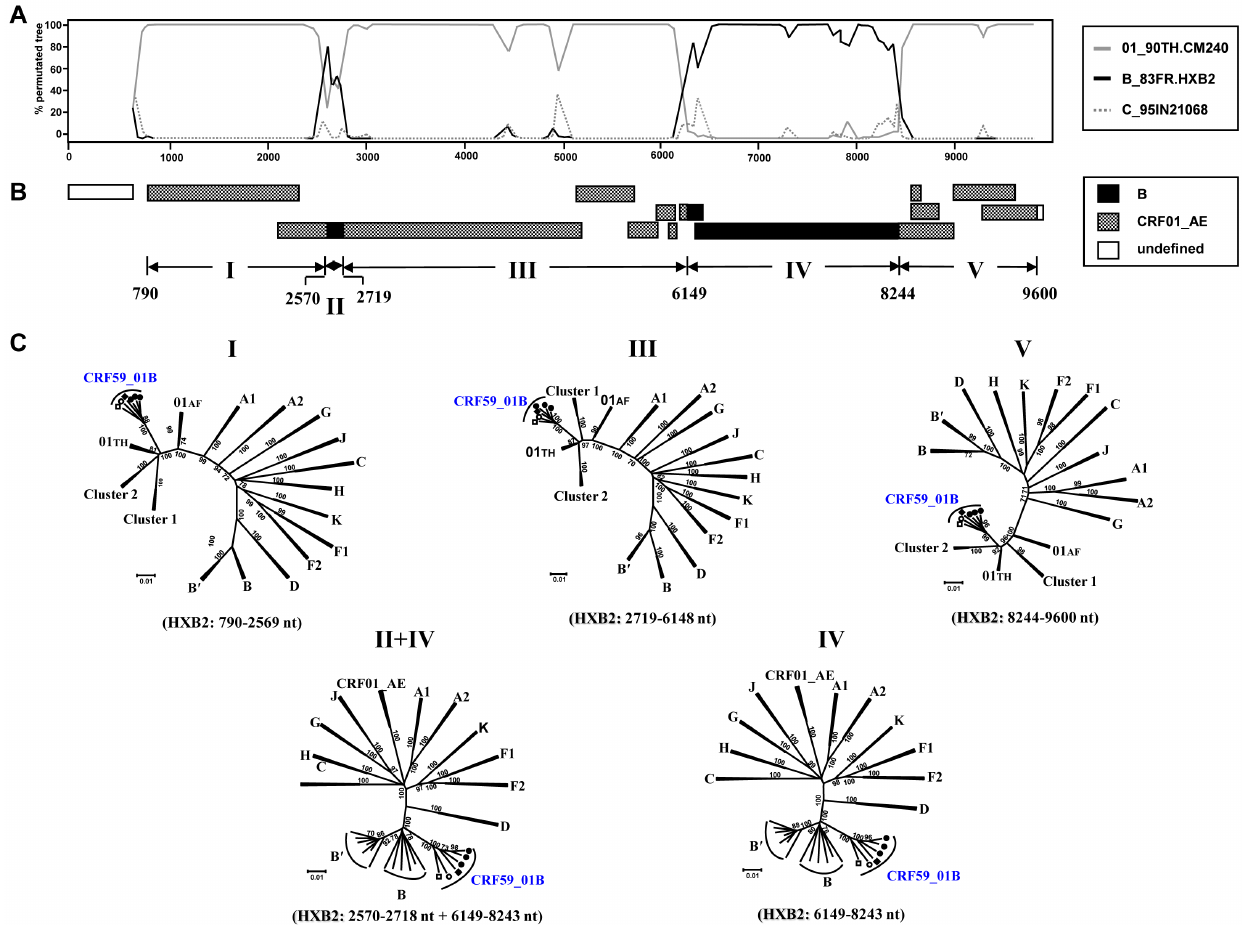
Figure 3. Recombination breakpoint analyses of CRF59_01B. (A) Bootscanning plot analysis. Analyses were performed using CRF01_AE (90TH.CM240) and subtype B (83FR.HXB2) as parental subtypes, and subtype C (95IN21068) as an out-group with a moving window of 350 nt with a step of 50 nt. Numbers represent nucleotide positions relative to the HXB2 genome. (B) The deduced subtype structure. Black=subtype B (of U.S.- European origin); gray=CRF01_AE; blank=no sequence data available. (C) Subgenomic phylogenies estimated using the neighbor-joining method from alignments representing Regions I, III, V (CRF01_AE) and the concatenated II + IV (subtype B) region. Bootstrap scores greater than 70% are indicated at corresponding nodes. 01 TH =Thailand CRF01_AE; 01 AF =African CRF01_AE; clusters 1 and 2=CRF01_AE variants associated with transmission among MSM in China.